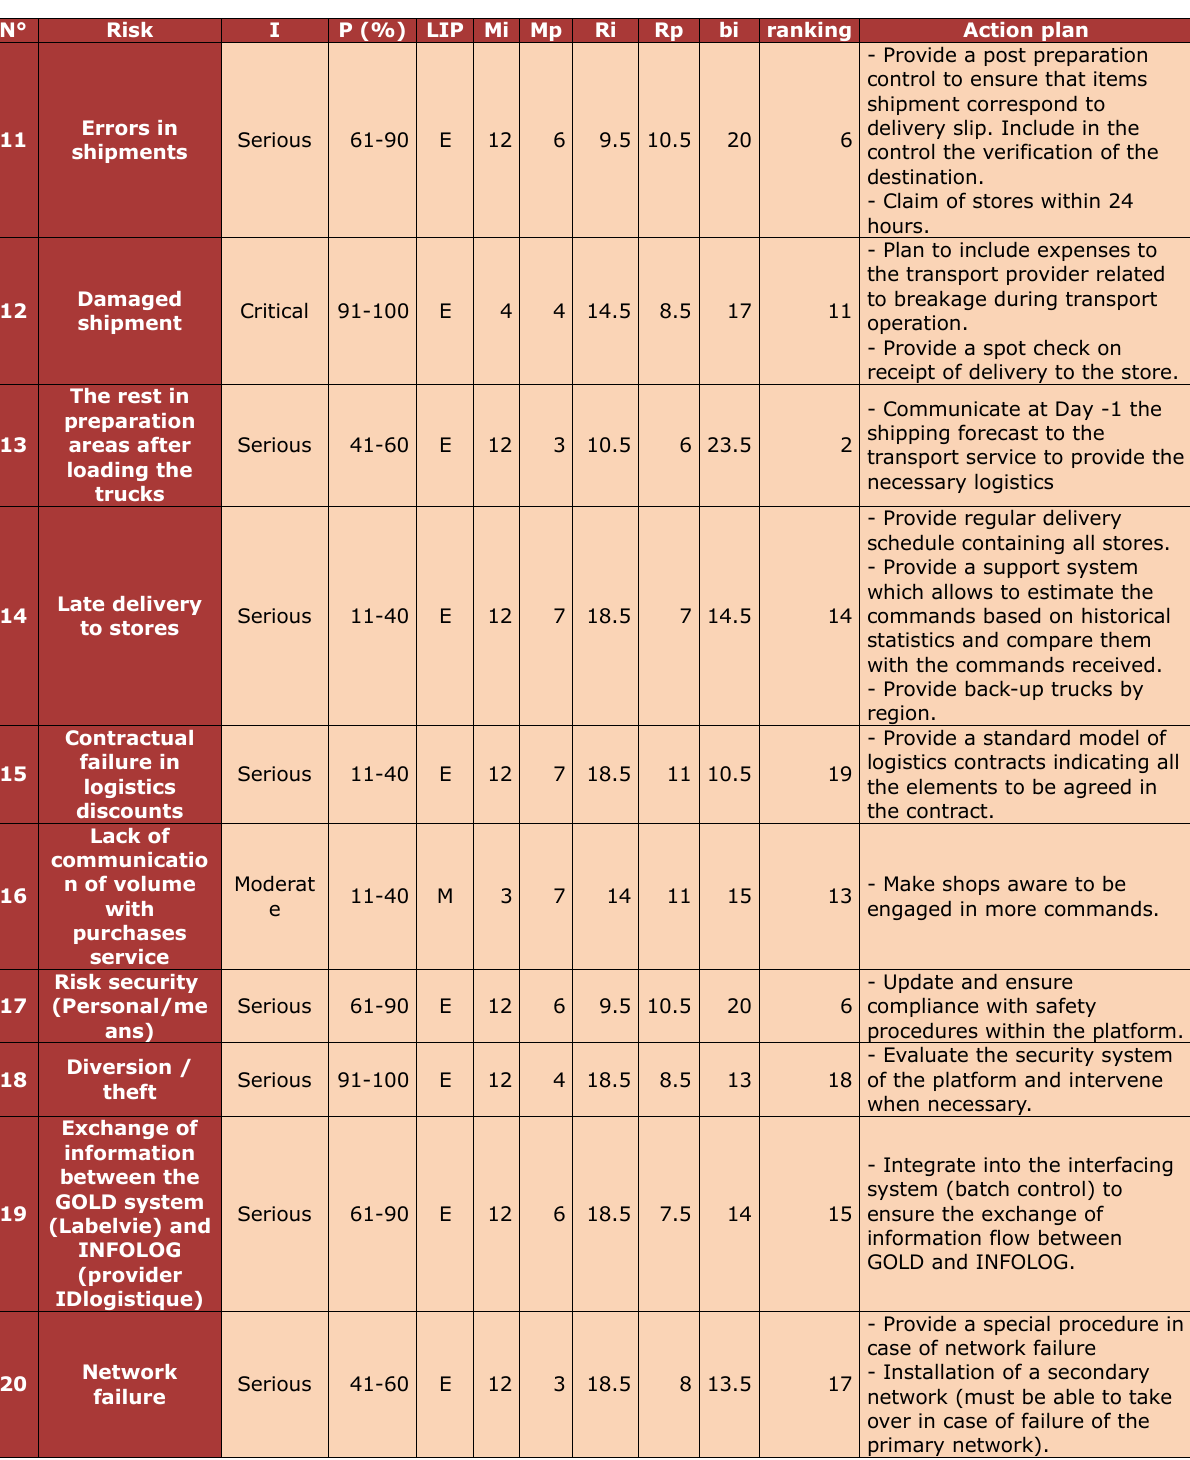
Table 5. Final Risk Matrix